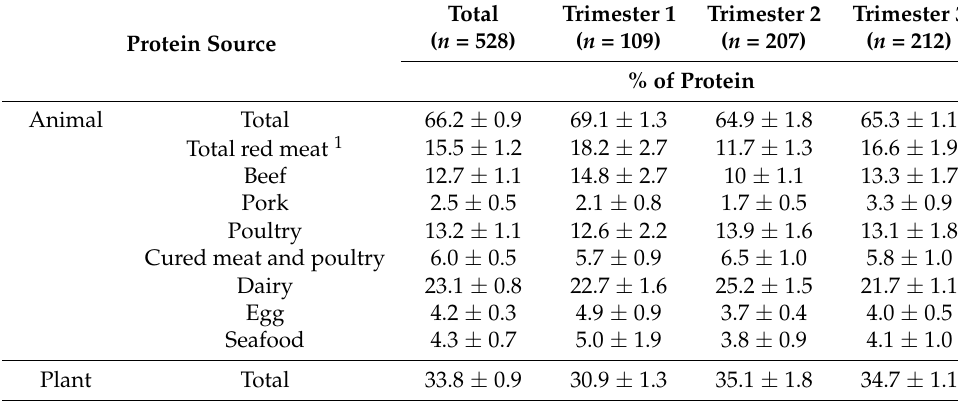
Table 4. Mean percent of protein intake by source among pregnant women ages 20–44 years in 2003–2012 National Health and Nutrition Examination Survey.